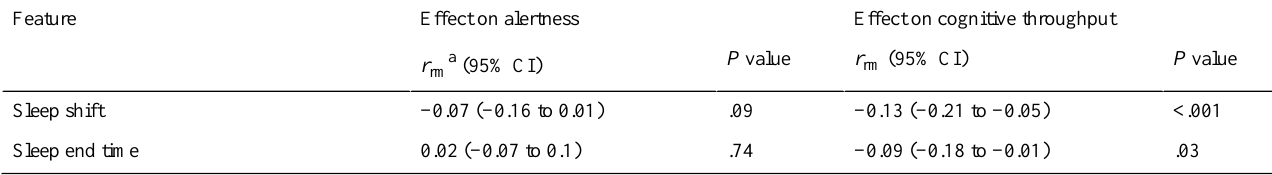
Table 5. Effect of sleep timings on daytime alertness and cognitive throughput.